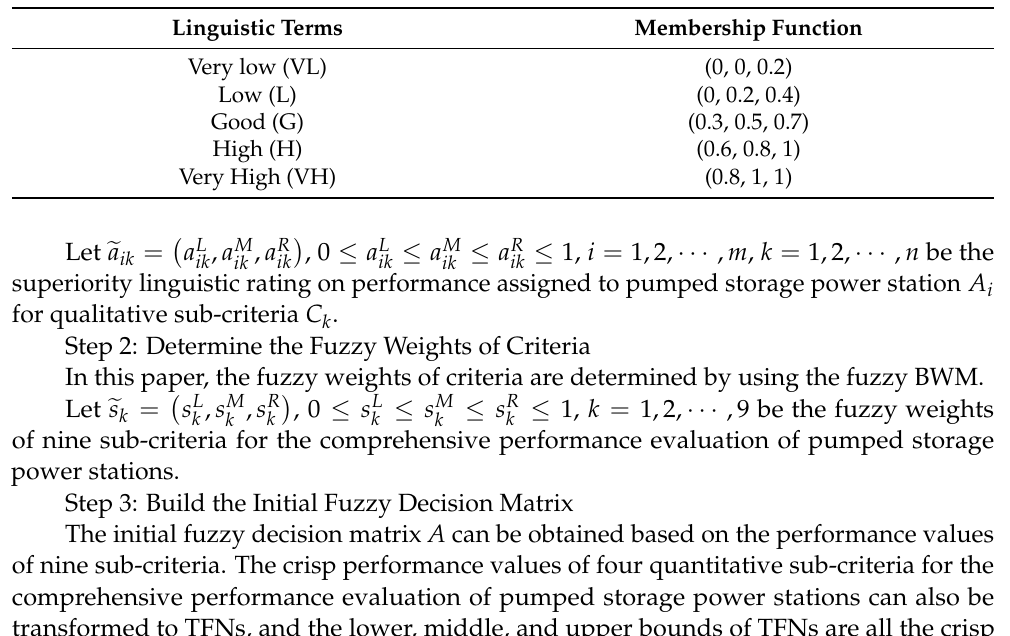
Table 2. Transformation rules of linguistic variables of expert panel for sub-criteria performance of